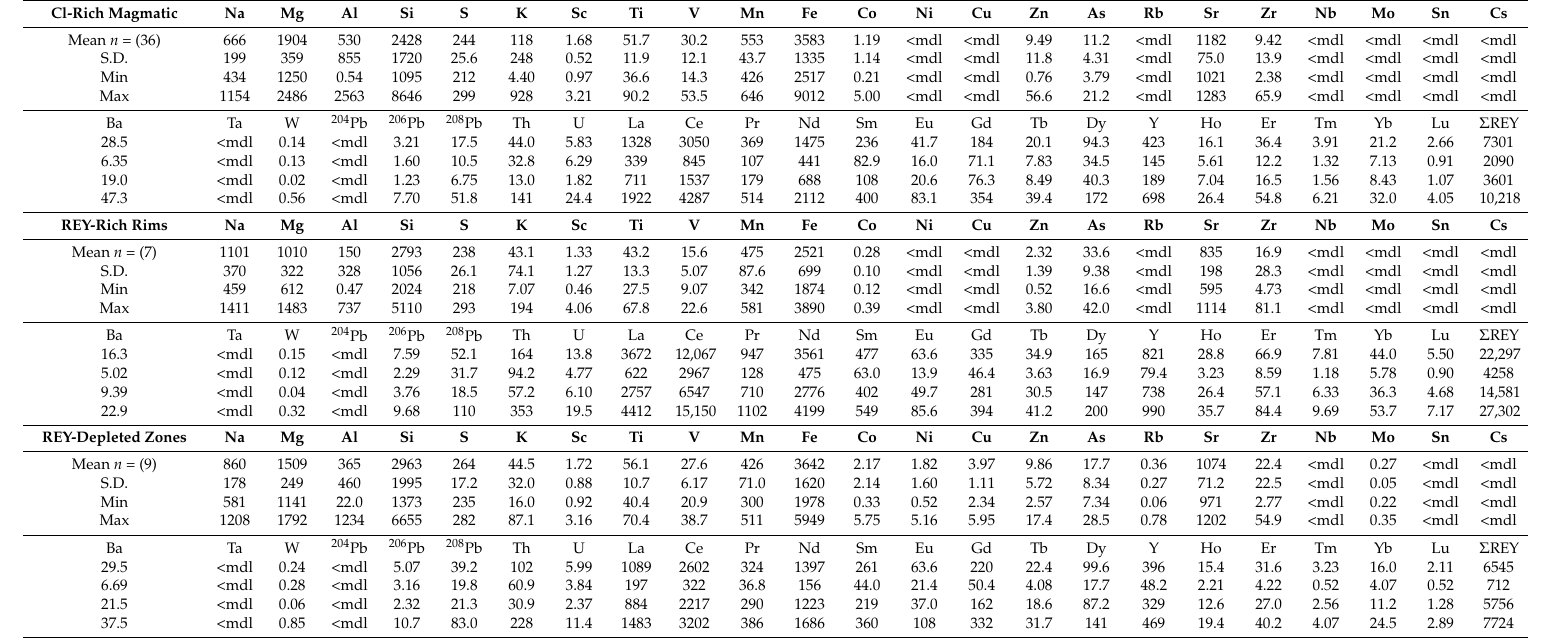
Table 4. REE and trace element concentrations in apatite from the dolerite dyke (ppm). Apatite analyses were performed on multiple grains in the following samples: Cl-rich magmatic—RX7913, RX7914; REY-rich rims—RX7913; Depleted zones—RX7913, RX7914. Cl-Rich